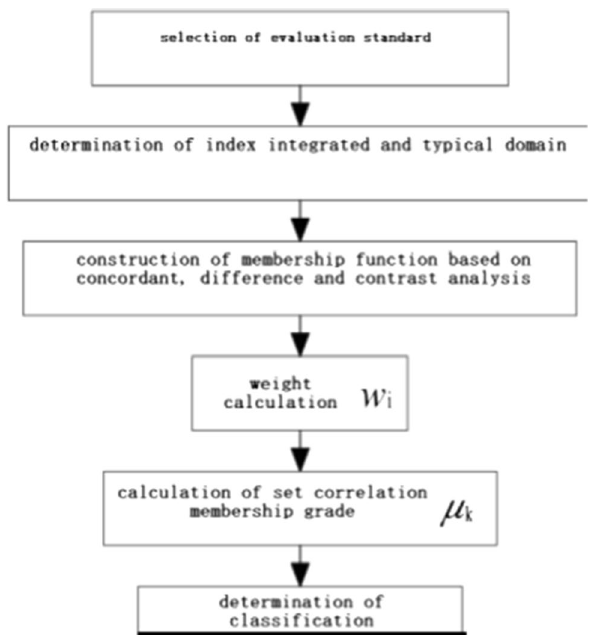
Fig. 2 Flow chart of evaluation process in improved coupling set